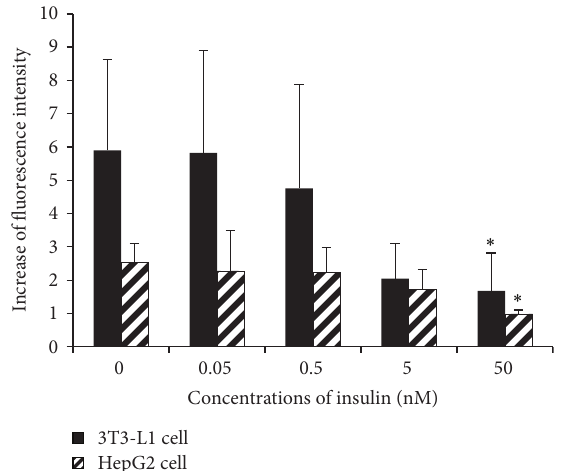
Figure 3: IR models of 3T3-L1 cell and HepG2 cell were established by hyperinsulinemic method (treated with 0, 0.05, 0.5, 5 and 50 nM insulin for 24 h), then stimulated by 100nM insulin for 15 min and the fluorescence of 2-NBD labeled glucose was examined. ∗ 𝑃 < 0.05 , compared with normal control group (without